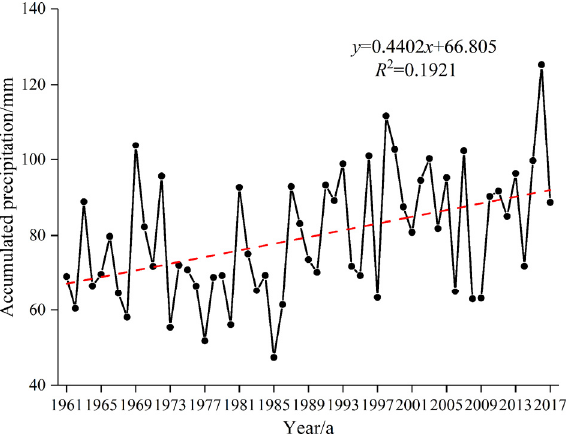
Figure 7. The time series of accumulated precipitation in summer during the 1961–2017 period across the CTMR (the precipitation data is from 31 meteorological stations within the CTMR). the CTMR (the precipitation data is from 31 meteorological stations within the